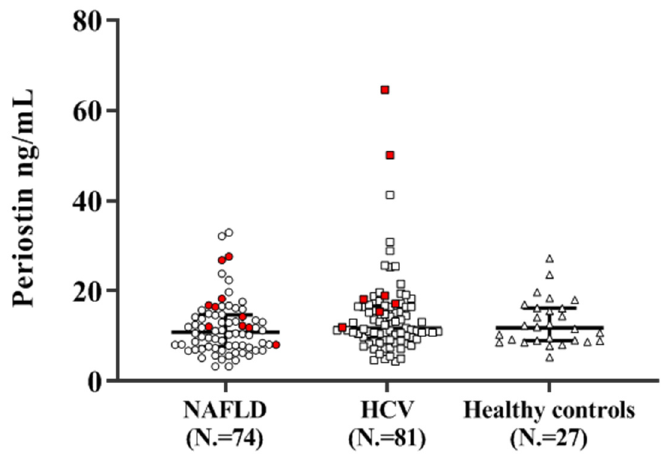
Figure 1. Scatterplot of the distribution of plasma periostin values according to the di ff erent disease etiologies. The red symbols identify cases of HCC. NAFLD: non-alcoholic fatty liver disease; HCV: hepatitis C virus. Table 4. (a): plasma periostin concentrations according to the severity of liver disease. Data are presented as medians (range). The p value refers to the di ff erences between the four considered disease stages. (b): di ff erences of PN circulating levels within the various fibrosis stages in non-HCC individuals. p values are reported. (c): di ff erences of PN circulating levels between HCC and non-HCC patients divided according to the various fibrosis stages. p values are reported.